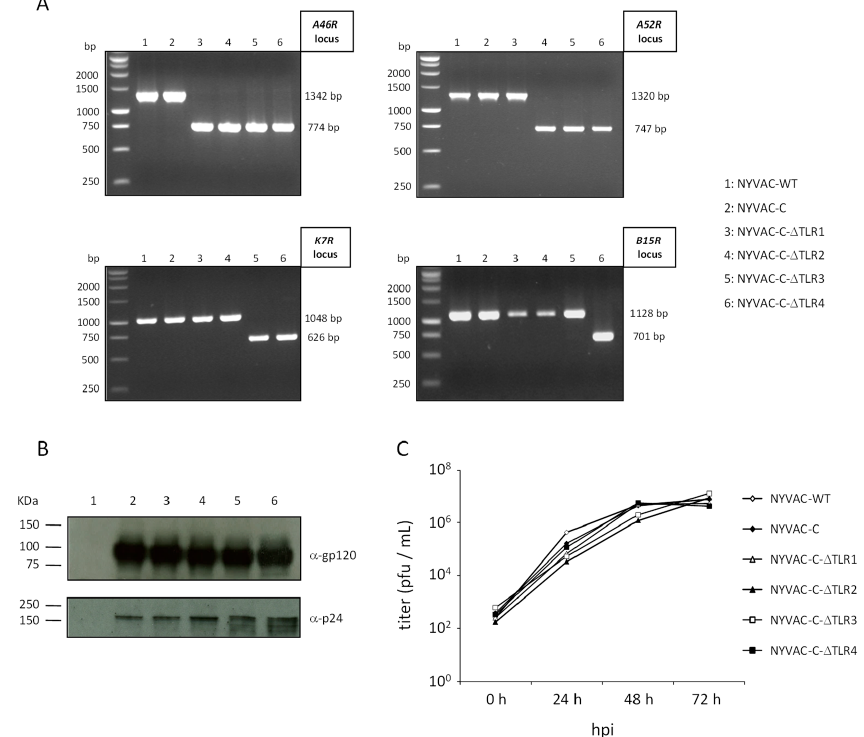
Figure 1. In vitro characterization of NYVAC-C deletion mutants involved in toll-like receptor (TLR) signalling inhibition. ( A ) Confirmation of A46R , A52R , K7R and B15R gene deletion by PCR analysis. Viral DNA was extracted from BSC-40 cells infected with NYVAC-WT, NYVAC-C or NYVAC-C deletion mutants (5 pfu/cell). Primers spanning gene flanking sequences were used for PCR analysis of A46R , A52R , K7R and B15R loci. Sizes obtained in parental NYVAC and in deletion mutants are indicated. ( B ) Western blot showing HIV antigen expression. BSC-40 cells were infected as in ( A ). At 24 h post-infection, cells were lysed in Laemmli buffer, cell extracts were fractionated by 8% SDS-PAGE and analysed in Western blot using polyclonal anti-gp120 antibody or anti-gag p24 serum to evaluate gp120 (120 kDa) and GPN (150 kDa) expression, respectively. ( C ) Analysis of virus growth in CEF cells. CEF cell monolayers were infected with NYVAC-WT, NYVAC-C or NYVAC-C- ∆ TLR1-4 (0.01 pfu/cell). At various times post-infection (0, 24, 48 and 72 h), cells were collected and infectious viruses quantified by immunostaining plaque assay in BSC-40